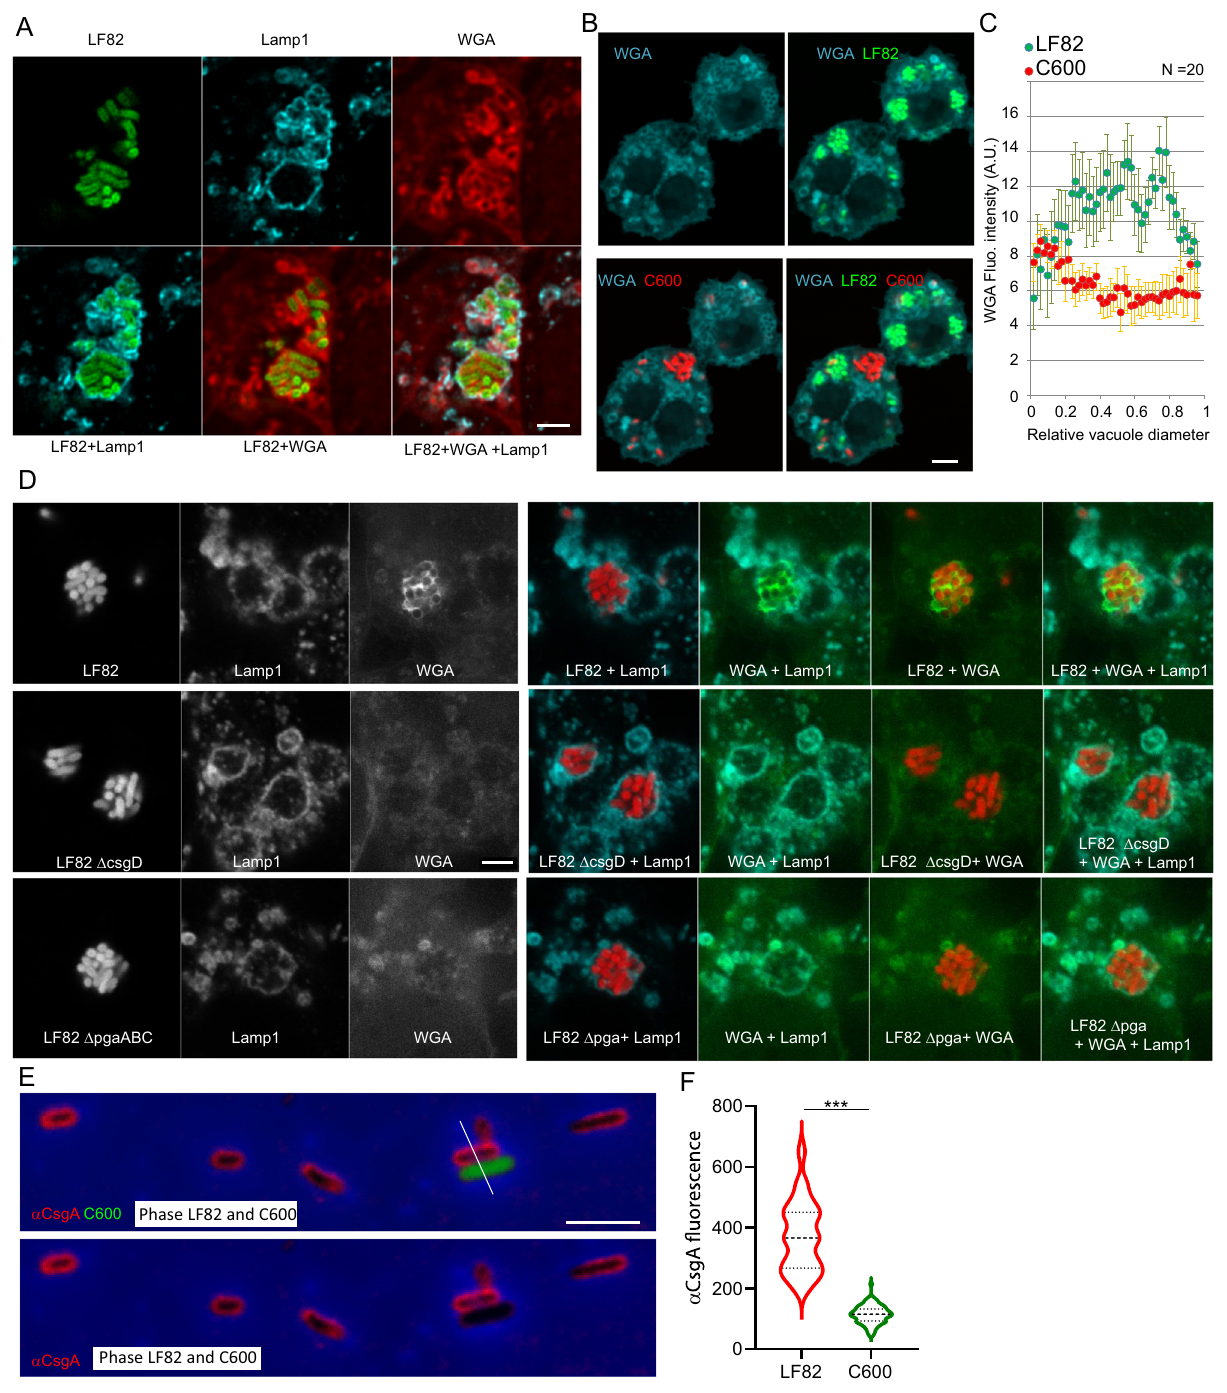
Fig. 3 Intracellular LF82 IBCs present a bio fi lm-like matrix. a Imaging of extracellular polysaccharide structures revealed by wheat germ agglutinin (WGA) labeling around LF82-GFP (green) inside phagolysosomes (antibody for Lamp1, cyan) of Raw macrophages. 24 h of P.I. b At 24 h of P.I. polysaccharide structures are observed inside phagolysosomes containing LF82-GFP but not inside phagolysosomes containing only C600-mCherry bacteria. c Quanti fi cation of the WGA fl uorescence intensity along the vacuole diameter of raw macrophages infected by LF82 or C600 for 24 h of P.I. Values represent median + / − SD of 20 vacuoles. d STED superresolution imaging of the extracellular polysaccharide structures revealed by WGA staining around LF82 IBCs formed by the WT and the csgD and pgaABC mutants. e Imaging of curli (antibody for CsgA, red) formed around LF82 during macrophage infection. Macrophages infected with LF82 and C600-GFP were lysed with Triton at 24h of P.I. before fi xation. f Quanti fi cation of the fl uorescence intensities along the cross section of LF82 and C600 (white line drawn in e ). N = 100 bacteria of a representative experiment, the data were analyzed using Student ’ s t -test: *** P < 0.001. The scale bars are 5 µ